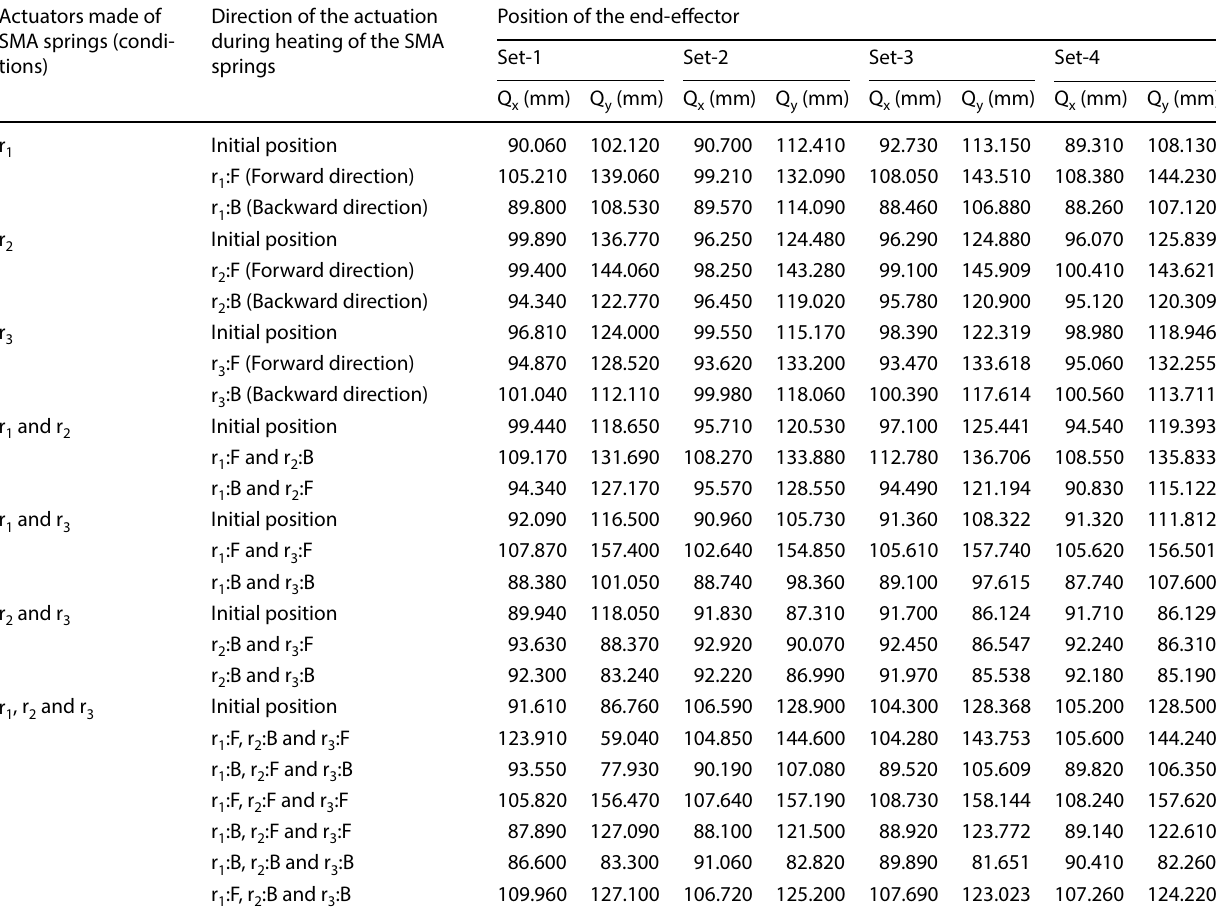
Direction of the actuation during heating of the SMA